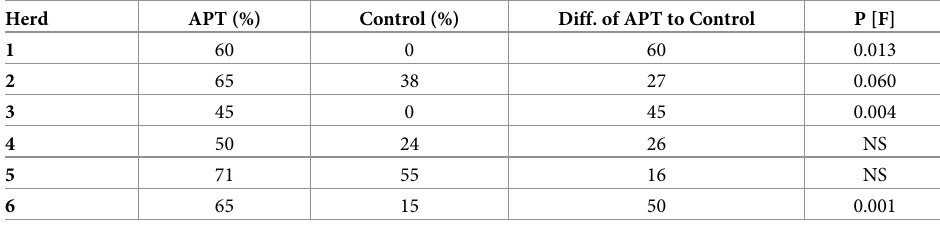
Table 2. Percent success, defined as > 75% reduction of cow-share-contribution in 2 out of 3 milk recordings fol- lowing treatment at each of the 6 herds of the 206 cows treated by APT or untreated (as control). Herd APT (%) Control (%) Diff. of APT to Control P [F] 1 60 0 60 0.013 65 38 27 0.060 45 0 45 0.004 50 26 NS 71 55 16 NS 65 15 50 0.001 APT–acoustic pulse